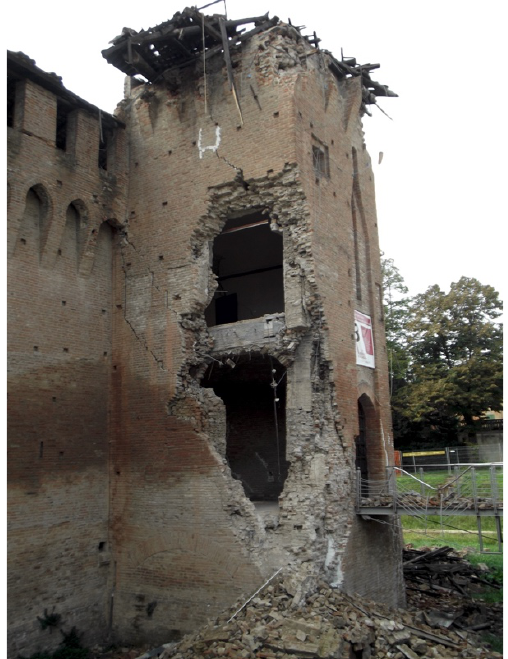
Figure 2. Seismic damages to the North Tower of